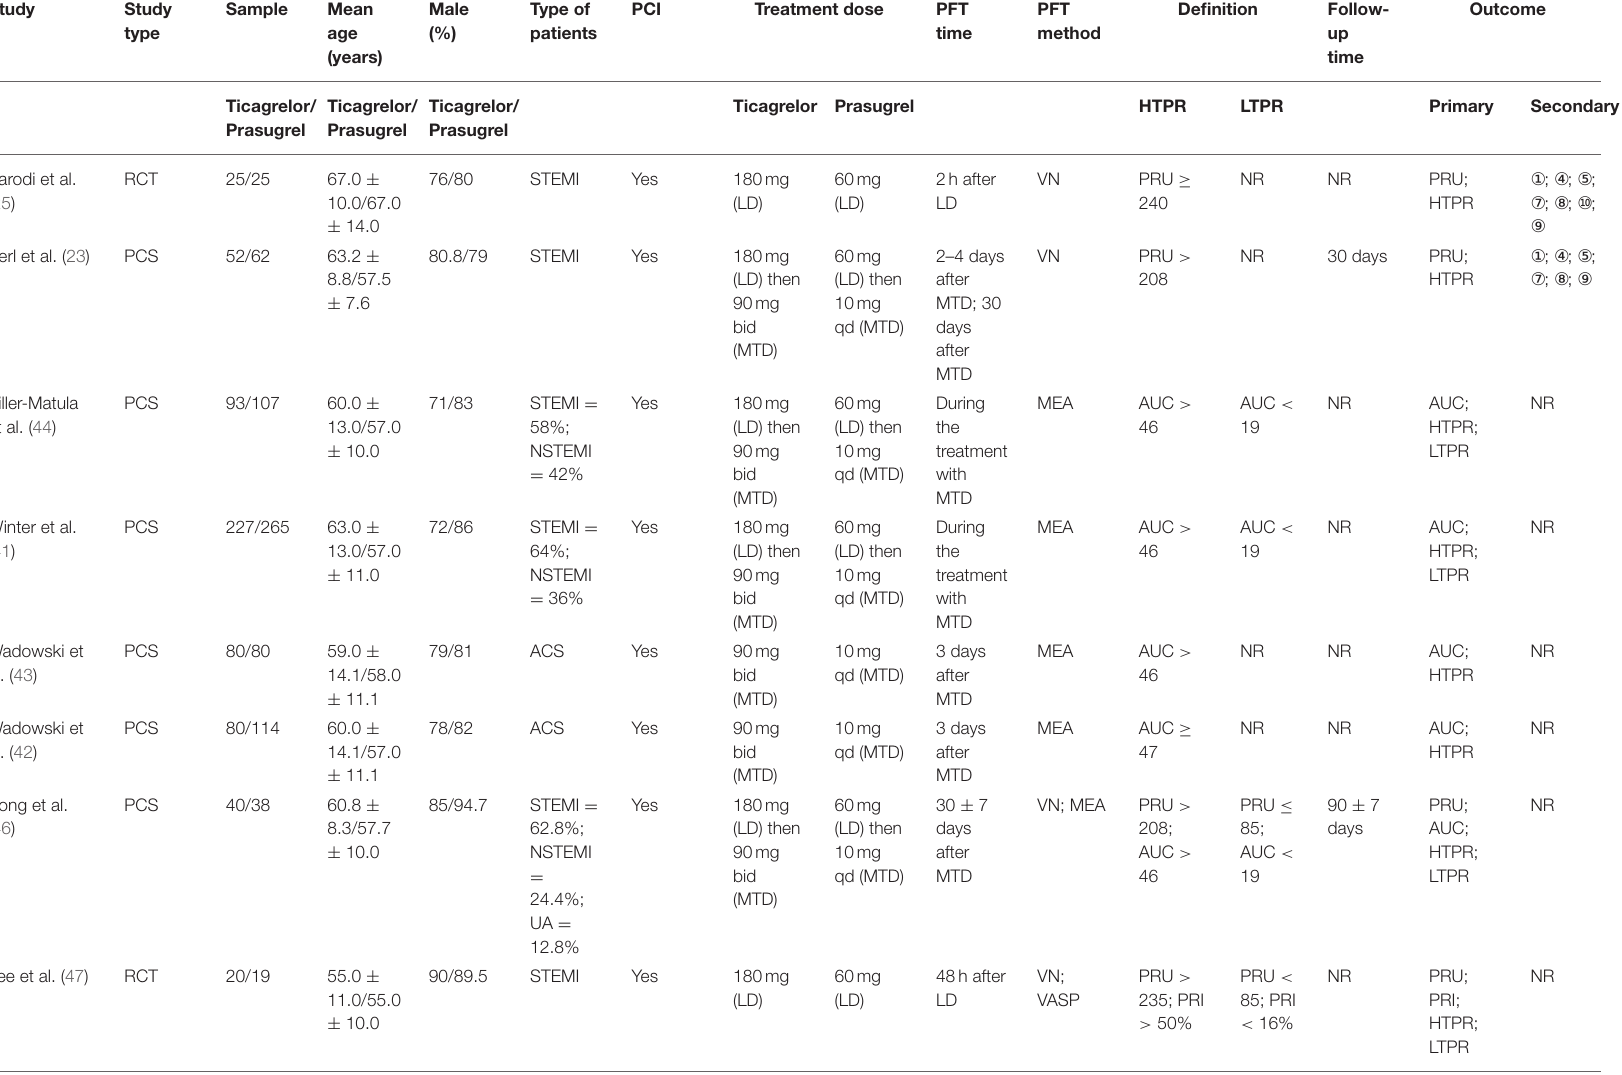
‹ All-cause death; › Bleeding BARC type 1; fi Bleeding BARC type ≥ 2; fl Cardiovascular death; (cid:176) Myocardial infarction (MI); – Stent thrombosis(ST); † Stroke; ‡ target vessel revascularization (TVR); · TIMI major bleeding; (cid:181) TIMI minor or minimal bleeding. CCI, Circulation: Cardiovascular interventions; JACC, Journal of the American College of Cardiology; P, Platelets; TH, Thrombosis and Haemostasis; CJ, Circulation journal: official journal of the Japanese Circulation Society; KJIM, Korean Journal of Internal Medicine; RCT, randomized controlled trial; PCS, prospective cohort study; RCS, retrospective cohort study; ACS, acute coronary syndrome; STEMI, st segment elevation myocardial infarction; NSTEMI, non-st elevation myocardial infarction; UA, unstable angina; PCI, percutaneous coronary intervention; LD, loading dose; MTD, maintenance dose; PFT, platelet function test; VN, verifynow P2Y12 assay; VASP, vasodilator-stimulated phosphoprotein test; MEA, multiple electrode aggregometry test; PRU, P2Y12 reaction unit; PRI, platelet reactivity index; AUC, area under the curve of aggregation tracing; HTPR, high on-treatment platelet reactivity; LTPR, low on-treatment platelet reactivity; NR, not